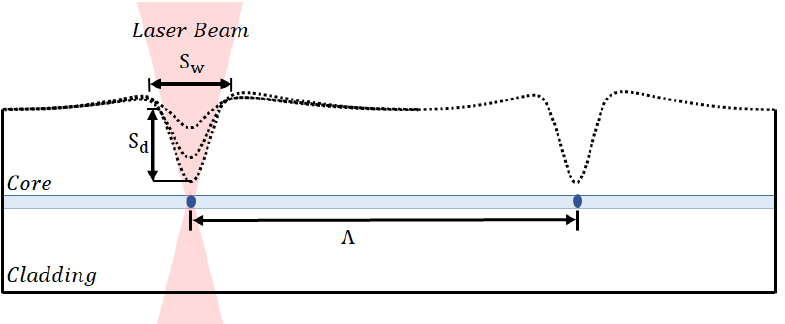
Figure 2. Schematic of the fiber under laser exposure during the LPFG manufacturing process. The relevant dimensions (parameters) are penetration depth (S d ), spot width (S w ), and grating period between spots ( ∧